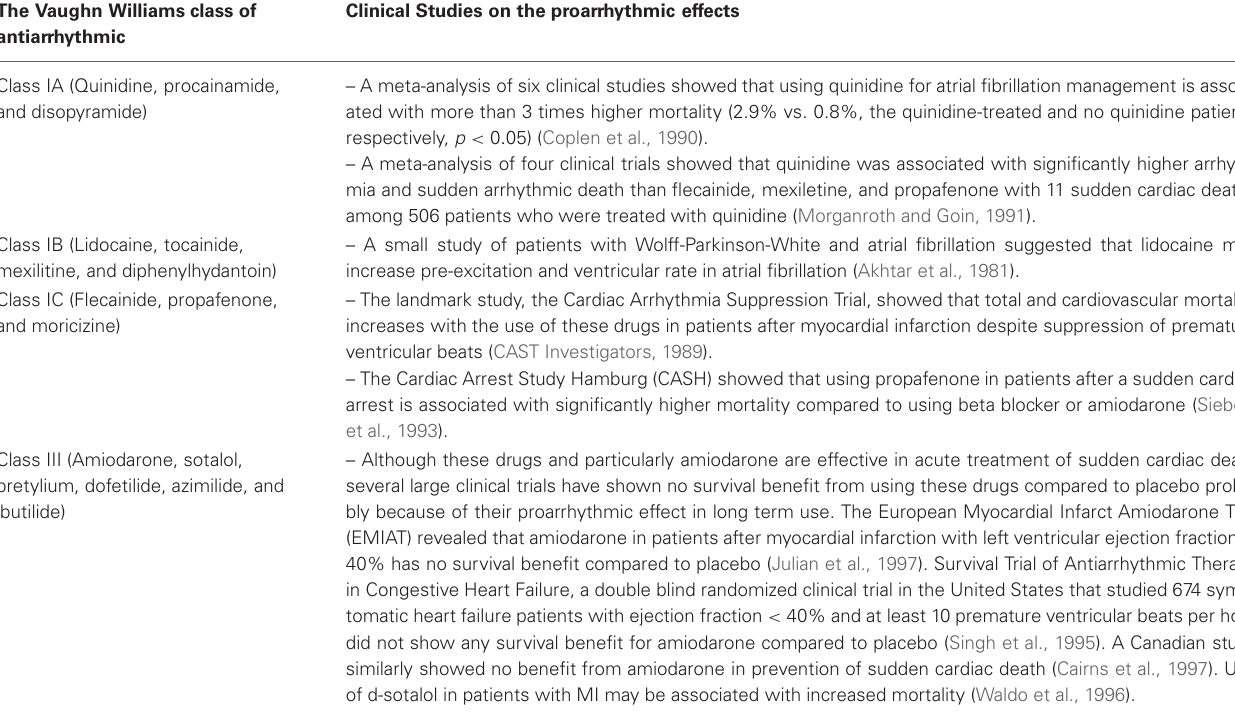
Table 2 | Clinical studies on the proarrhythmia of antiarrhythmic drugs. The Vaughn Williams class